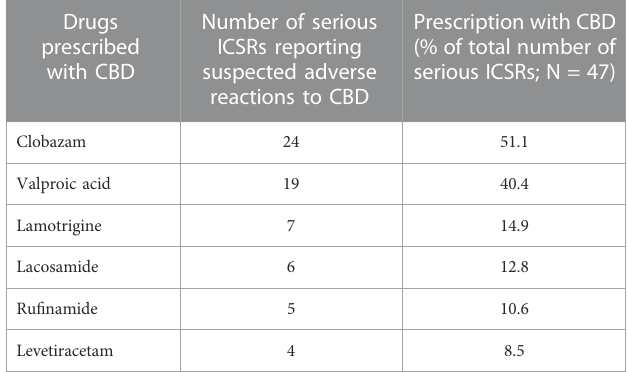
TABLE 4 Drugs more frequently prescribed in serious individual case safety reports (ICSRs) reporting suspected adverse reactions (SARs) related to cannabidiol (CBD) use as an antiepileptic drug in the years 2019 –